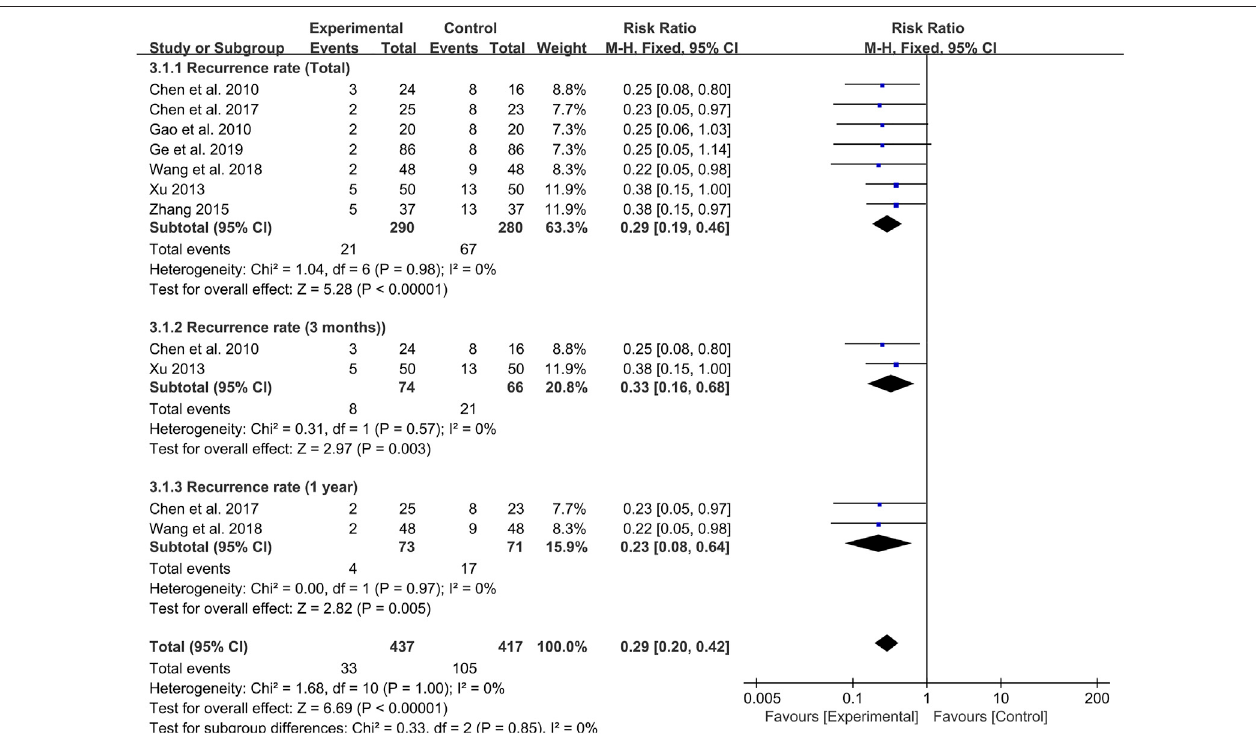
FIGURE 6 | Forest plot displaying the results of the meta-analysis for recurrence